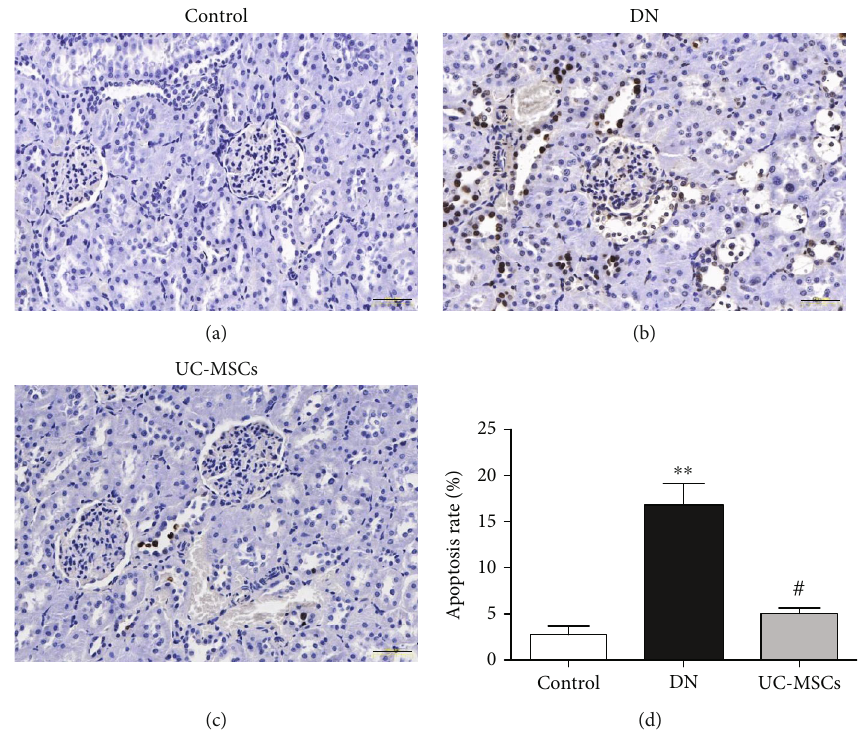
Figure 4: Renal cell apoptosis was detected by the TUNEL assay (a – c) and quanti fi ed as the percentage of apoptotic cells (d), scalebar = 50 μ m ( n = 5 , ∗∗ p < 0 : 01 versus control group, # p < 0 : 05 versus DN